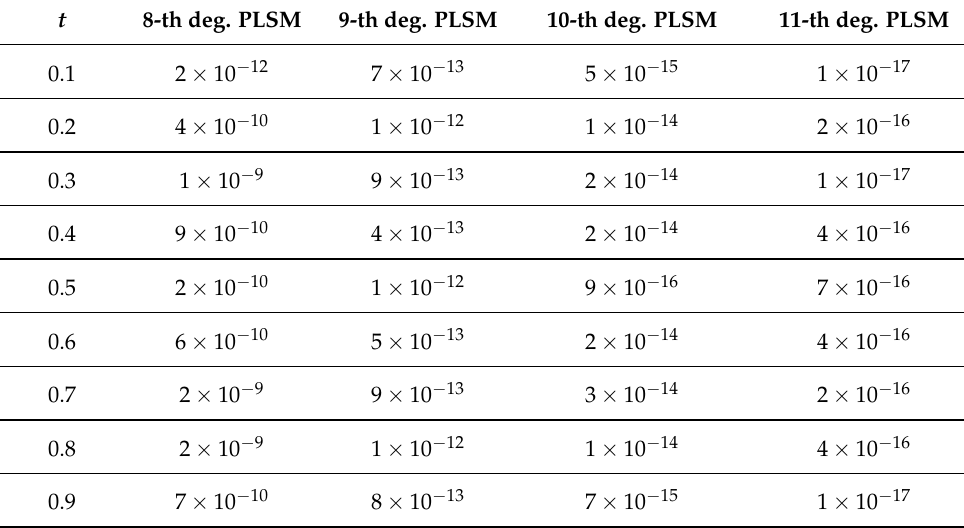
Table 4. Comparison of PLSM absolute errors of x 2 for problem (17) in the case α 1 = α 2 =